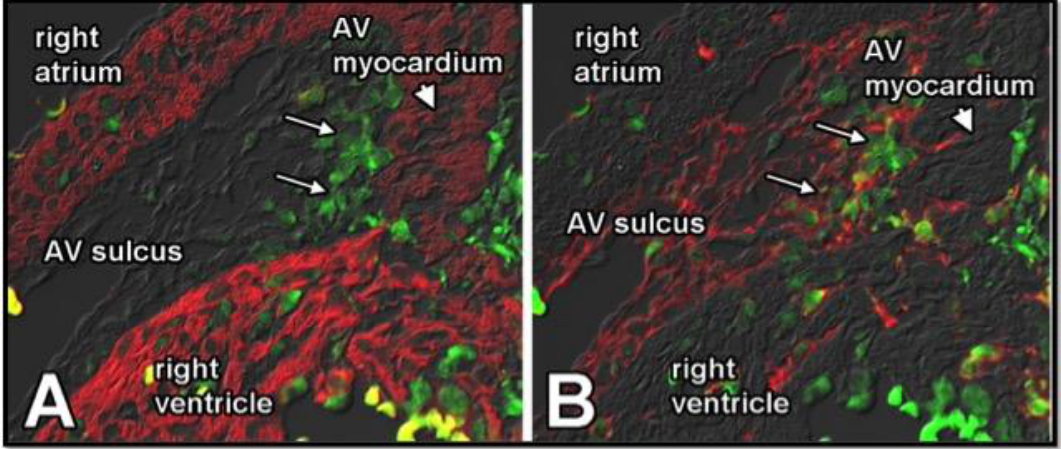
Figure 6. MMP2 expression in AV-EPDC in the AV sulcus. Sister sections of a Wt1 cre ;R26 mG heart were stained for MMP2 (green in ( A , B )), myosin (red in ( A )), and EGFP (to delineate EPDCs, red in ( B ). The figure shows that MMP2 is upregulated in the AV-EPDC as they are migrating toward the AV myocardium.